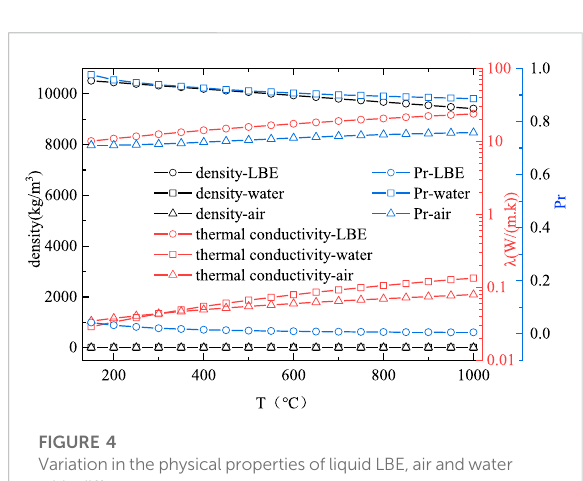
FIGURE 3 Comparison of heat transfer correlations and the fi tted curve in Figure 2.